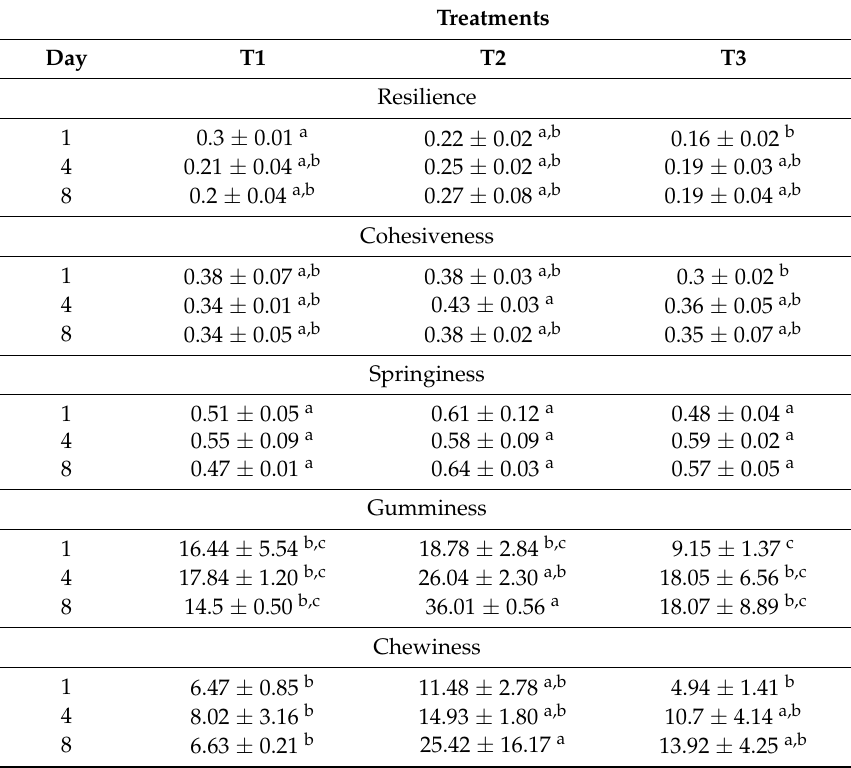
Data are given as mean values ± standard deviation ( n = 3). Different letters within the same row indicate significant differences (Tukey’s Test, p < 0.05) between mean values. T1, control; T2 surimi-based coating without MMT; T3, surimi-based coating with MMT.